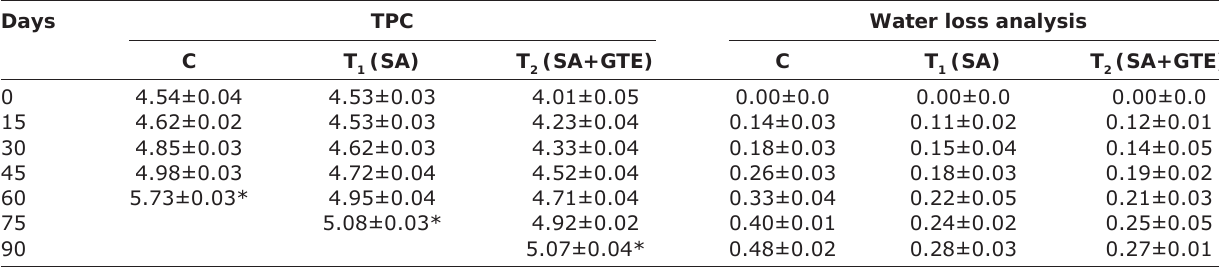
Table-4: TPC and water loss analysis (mean±SE) values of chicken meat nuggets as influenced by different coatings during frozen ( − 18±1°C) storage. Days TPC Water loss